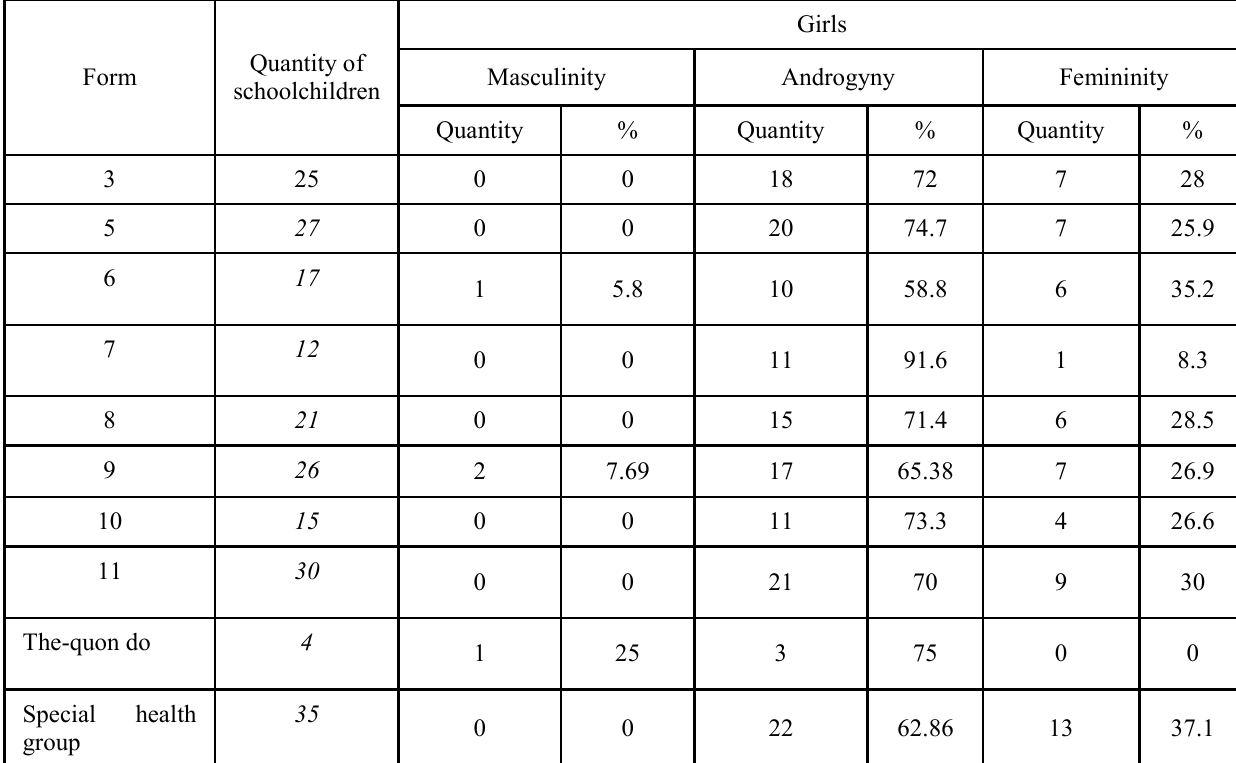
Results of gender identity’s research (by